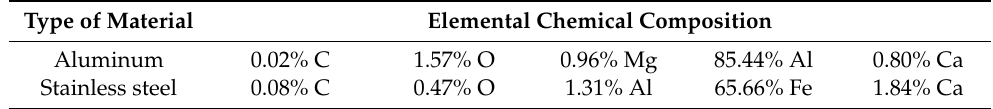
Figure 8. EDX mapping fracture image of: ( a ) the aluminum sample; ( b ) stainless steel sample. Table 4. The chemical composition of the samples